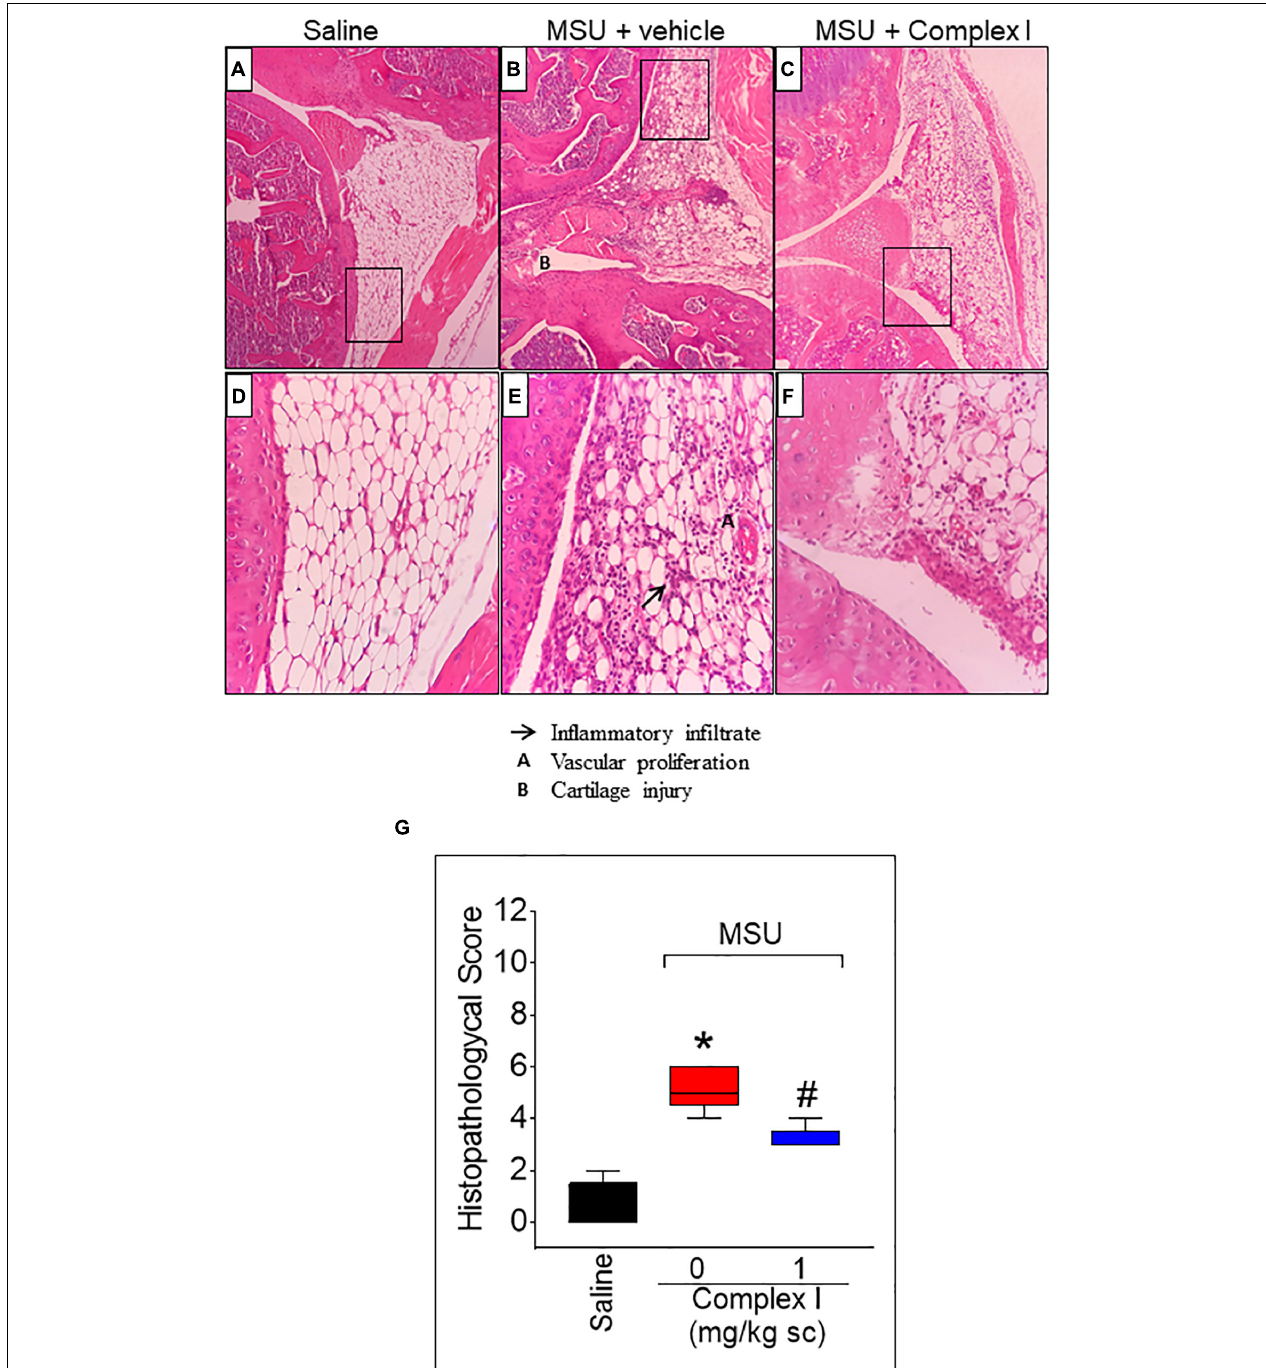
FIGURE 4 | Effect of complex I treatment on histopathology profile alterations in synovial tissue of MSU-induced arthritis in mice. Mice were treated with complex I (1 mg/kg/saline, s.c.) or vehicle 30 min prior to intra-articular stimulation with MSU (100 µ g/10 µ l) and after 15 h knee joints samples were collected to the histological analysis and score. The sections were stained with Hematoxylin – Eosin. Original magnification 10 × (A–C) and 40 × (D–F) and the figures are representative of all experiments. The groups are represented as saline (A,D) , MSU + vehicle (B,E) , MSU + complex I (C,F) . The panel (G) indicates the histopathological score. The parameters analyzed were (arrow) inflammatory infiltration; (A) vascular proliferation; and (B) cartilage injury. Results are expressed as mean ± SEM ( n = 5 per group per experiment, representative of two experiments). ∗ p < 0.05 compared to saline group and # p < 0.05 compared to MSU + vehicle. One-way ANOVA followed by Newman–Keuls